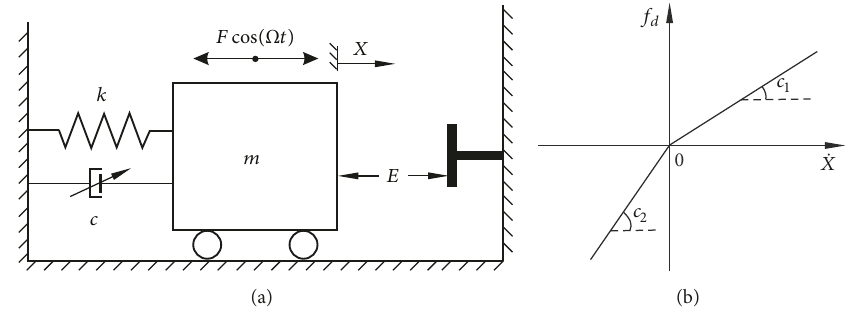
Figure 1: (a) Physical model and (b) the dual-rate damper